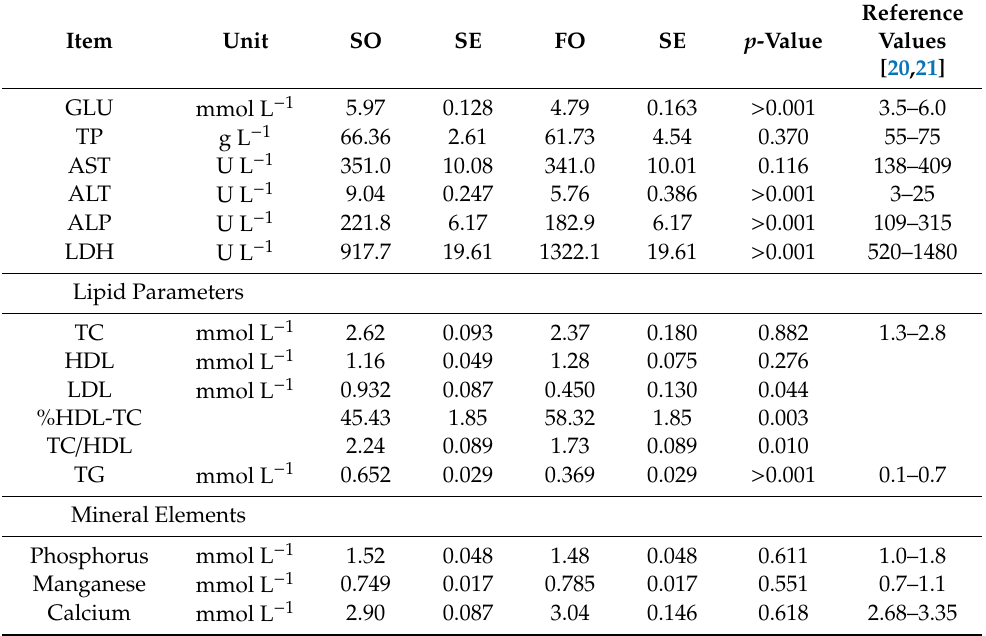
Table 2. E ff ect of dietary oils on biochemical parameters (mean ± SE) of the blood plasma of horses.